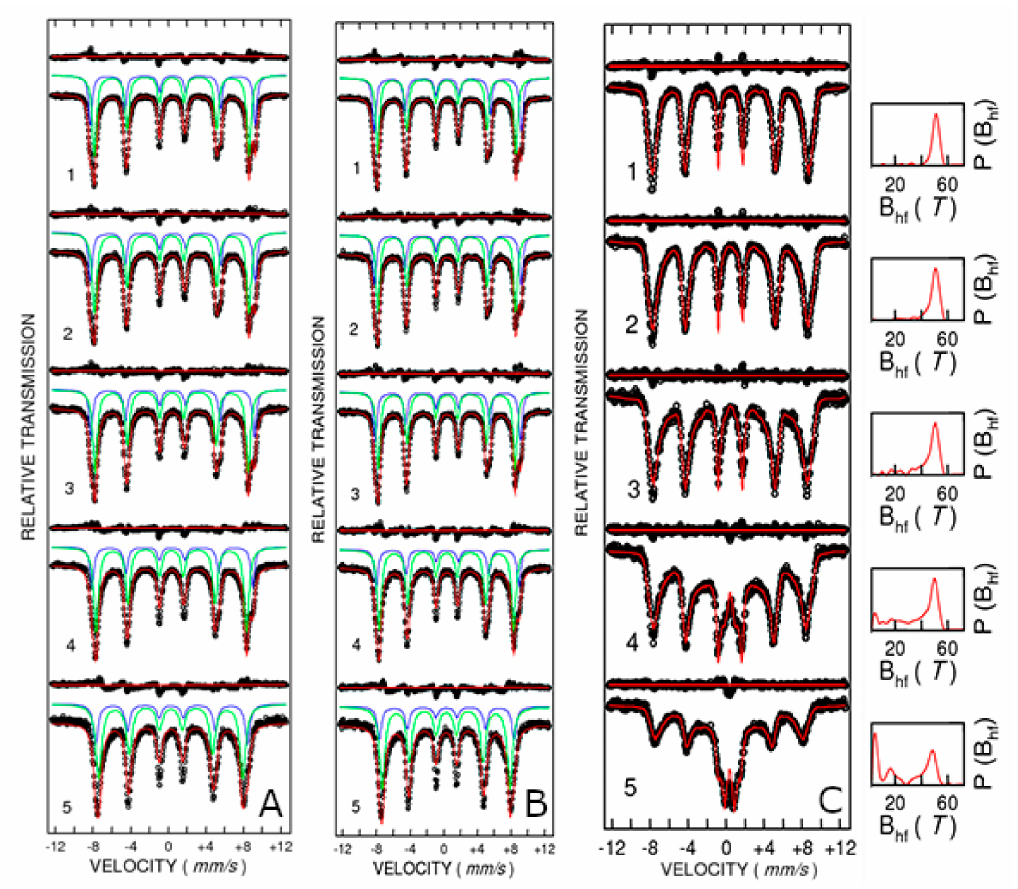
Figure 8. Mössbauer spectra at selected temperatures: 10 K (1), 50 K (2), 100 K (3), 200 K (4), 300 K (5) for samples CFO83 ( A ), CFO93 ( B ), and CFO73 ( C